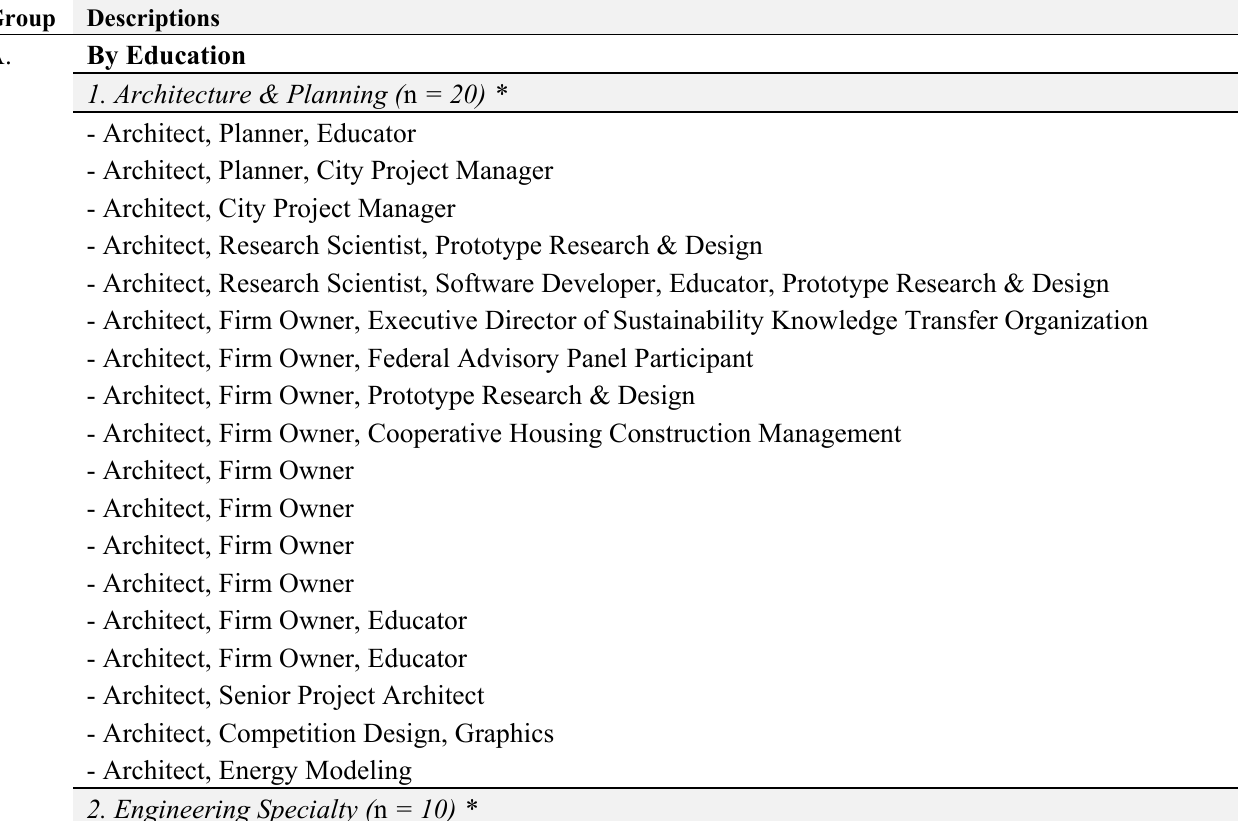
Table 1. Descriptions of heterogeneous actors